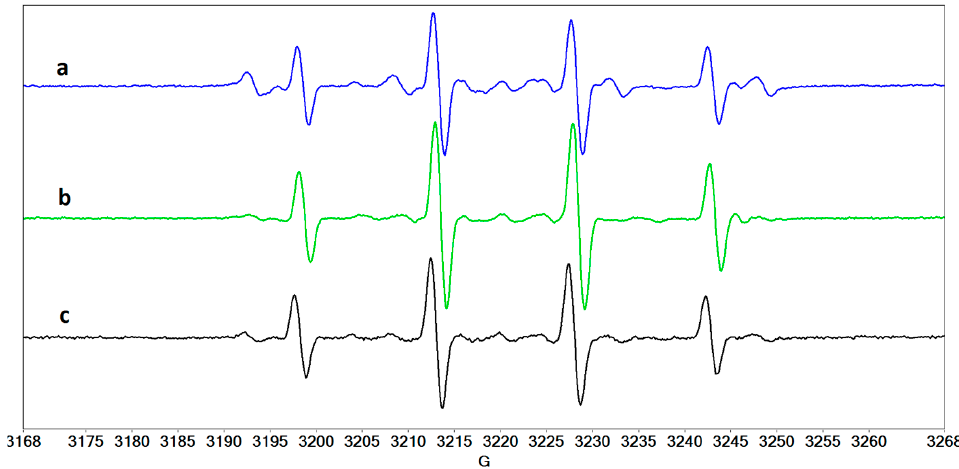
Figure 9. The EPR spectra of DMPO adducts formed after UVA exposure, in the presence of ribo- flavin, of a solution of ( a ) HSA, ( b ) LF, ( c ) LYZ, and of the mixture of the three proteins in the ab- sence ( d ) and in the presence ( e ) of hyaluronic acid.